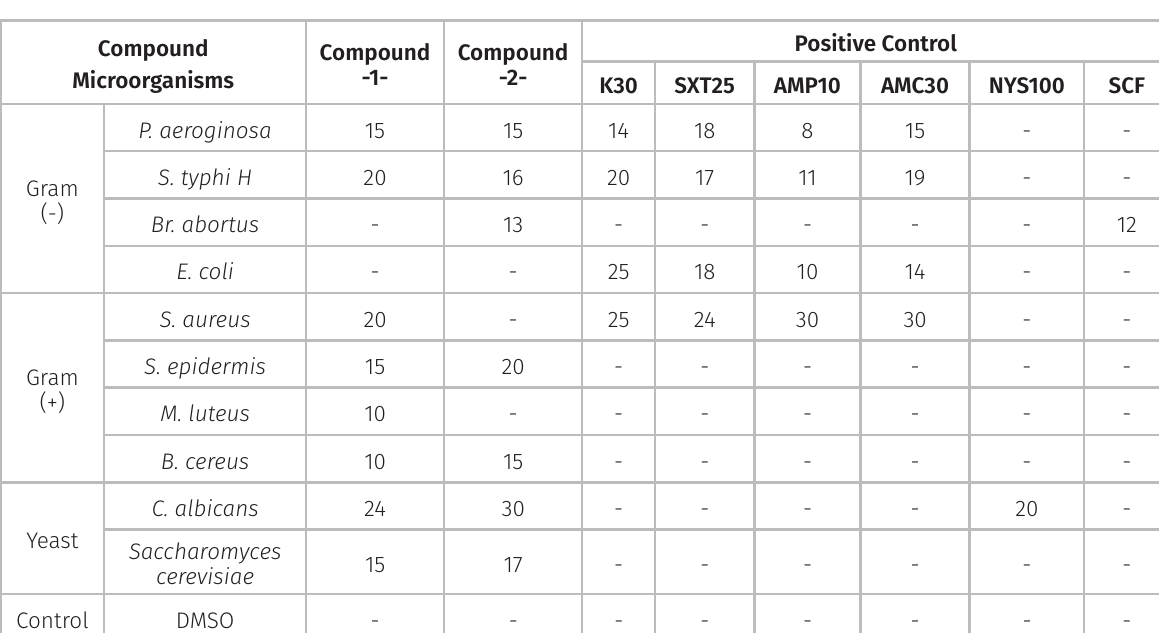
Table III. Biological activity of compounds (compound I and II) and standard reagents (diameter of zone inhibition